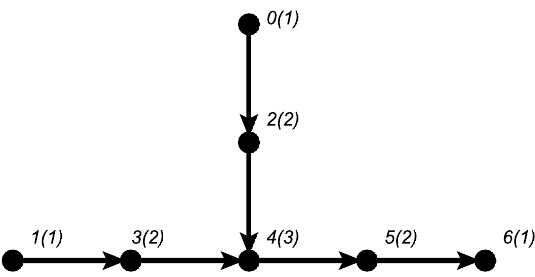
Figure 2. Oriented b E 6 quiver. The numbers in the parentheses represent the Coxeter labels d i .